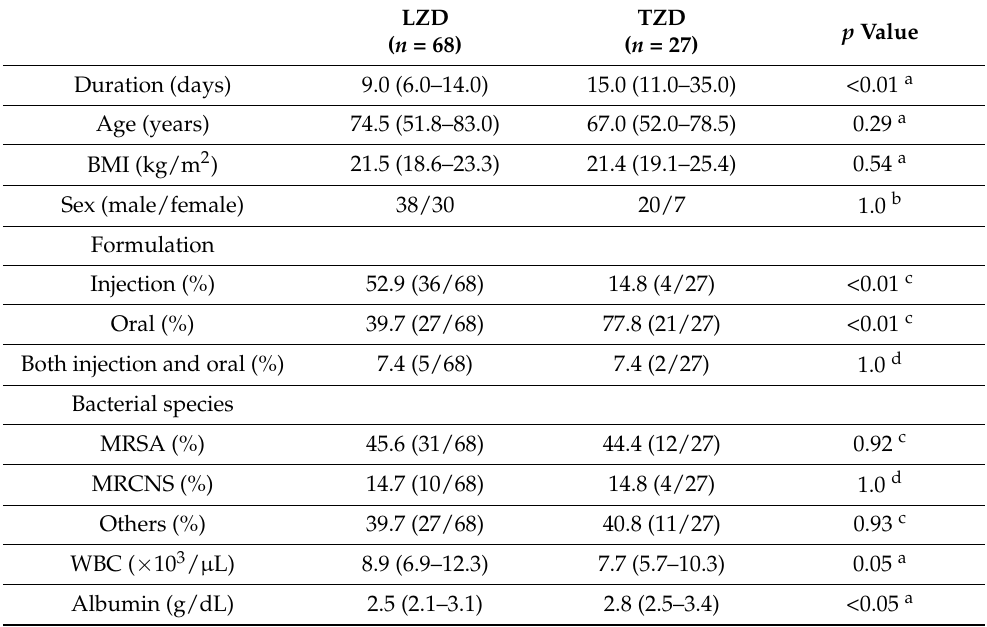
Table 1. Clinical characteristics of patients.